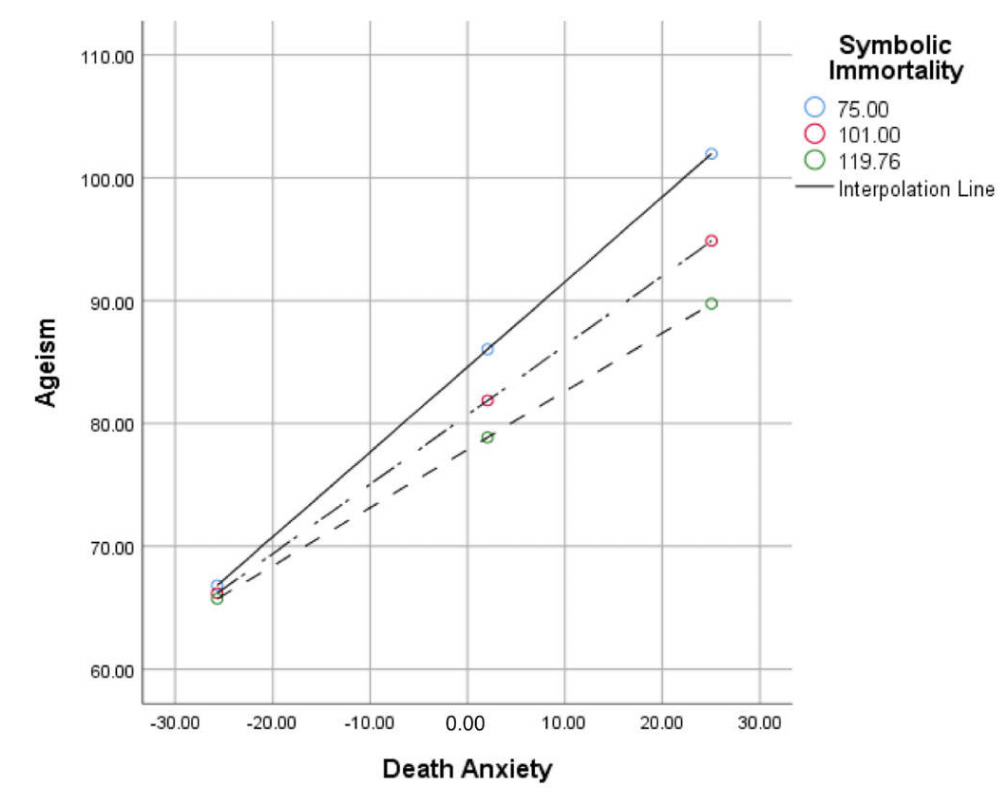
Figure 2. The relationship between death anxiety and symbolic immortality at low, moderate, and high levels. Y axis exhibits total score on Ageism. X axis exhibits mean-centered CL–FODS